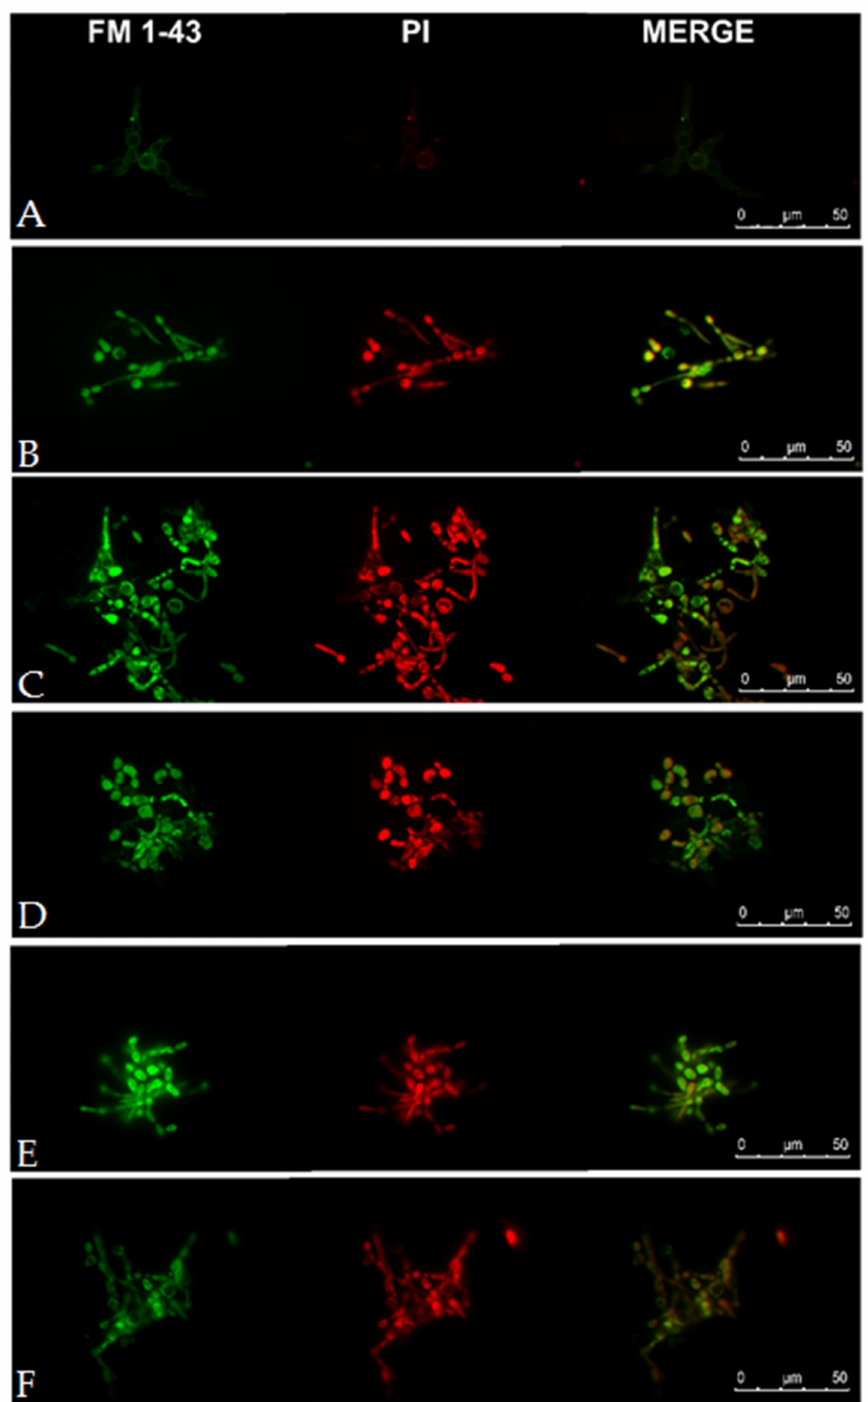
Figure 9. Fluorescence microscopy images of C. albicans ATCC 10231 cells. ( A )—no additive, negative-control; ( B )—melittin as positive control; ( C )—lipopeptide L2 ; ( D ) 4—lipopeptide C2 ; ( E )—lipopeptide L4 ; and ( F )—lipopeptide C4 . FM 1-43 is an amphiphilic styryl green fluorescent dye that can be used to stain plasma membranes and organelle membranes in fungal cells [62]. PI needs to bind to double-stranded DNA to emit red fluorescence and cannot cross intact plasma membranes. Negative control reveals a faint green fluorescence of FM 1-43 integrated with plasma membrane and absence of red fluorescence (PI)